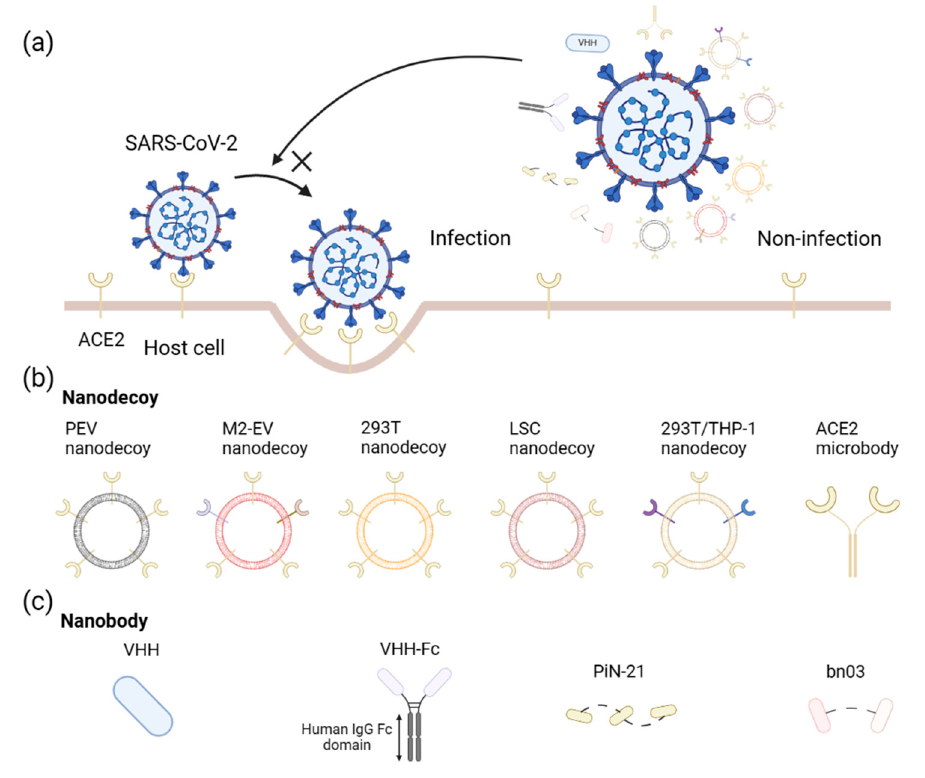
Figure 1. Nanodecoys and nanobodies targeting the S protein of SARS-CoV-2. ( a ) Nanodecoys and nanobodies prevent SARS-CoV-2 variants from binding to ACE2, protecting host cells from infection. ( b ) Nanodecoys: nanodecoys based on EVs and different membranes, including 293T [8], LSC [9], and 293T/THP-1 [10], an ACE-2 microbody containing two ACE2 receptors. ( c ) Nanobody: a single nanobody, nanobodies were conjugated to IgG Fc, a trimer containing three nanobodies, heterodimers of nanobodies.